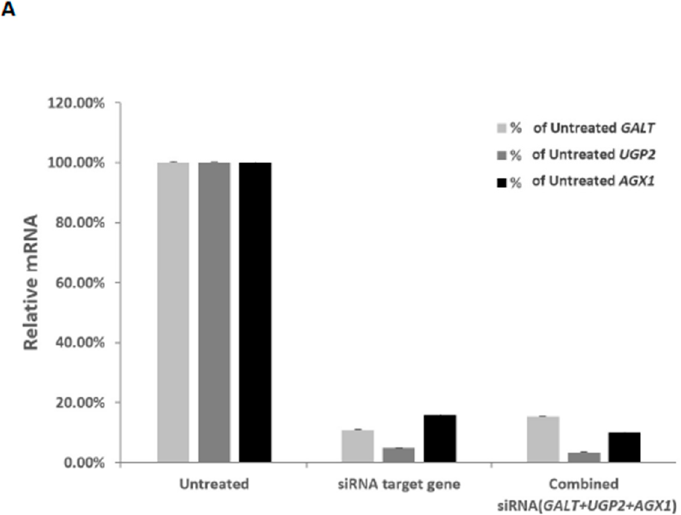
Figure 4. Cont Figure 4. Cont. Figure 4. Cont.